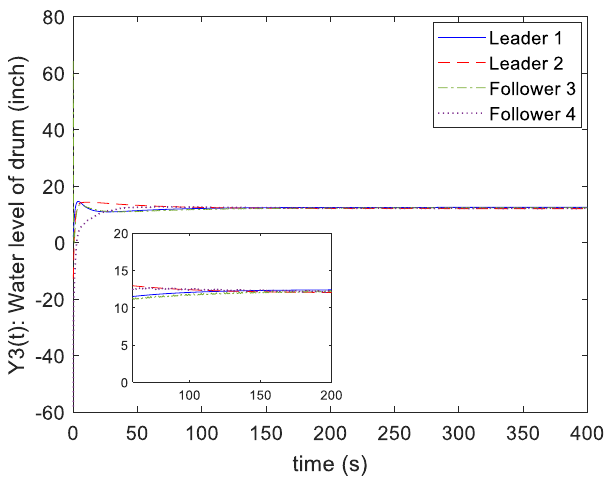
Y t with IT-2 fuzzy control. 2